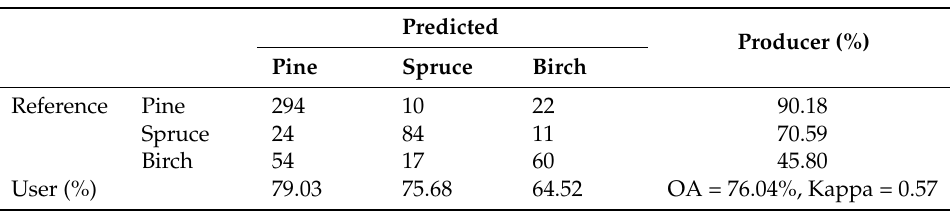
Table 4. Confusion matrix and accuracy evaluation of classification with 15 selected point cloud features and test data.